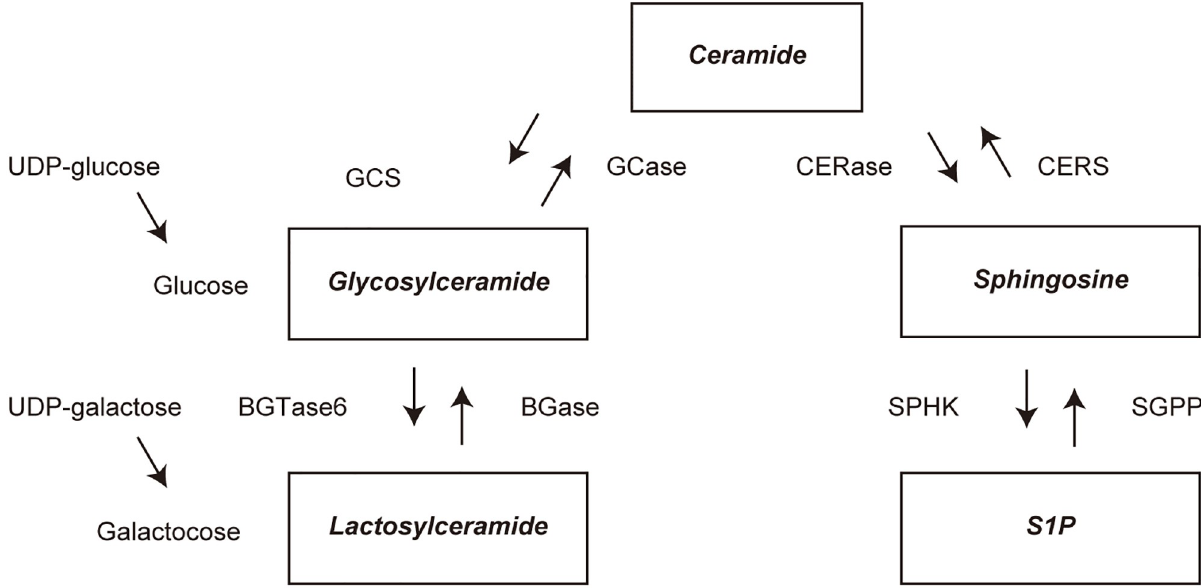
Fig 5. Ceramide, sphingosine and glycosphingolipid metabolism. Products are indicated in bold and italics. Abbreviations: S1P, sphingosine- 1-phosphate; GlcCer, glucosylceramide; GCase, glucocerebrosidase; GCS, GlcCer synthase; CERase, ceramidase; CERS, ceramide synthase; SPHK, sphingosine kinase; SGPP, S1P phosphatase; BGTase6, beta-1,4-galactosyltransferase 6; BGase, beta-galactosidase.